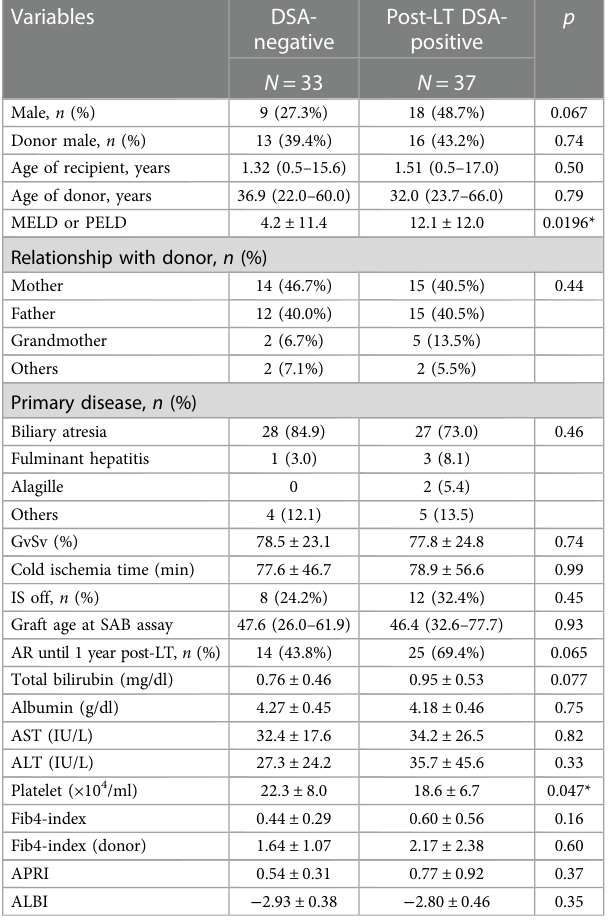
TABLE 1 Characteristics of the pediatric LDLT recipients who developed post-LT DSA.